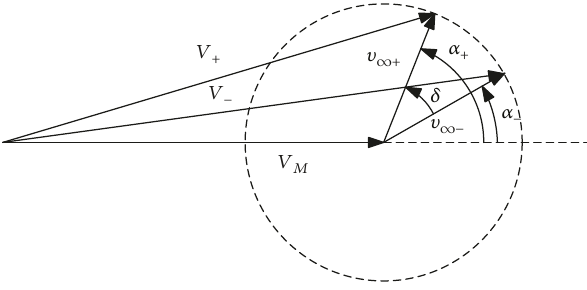
Figure 3: Velocity before ( − ) and after ( + ) the fl